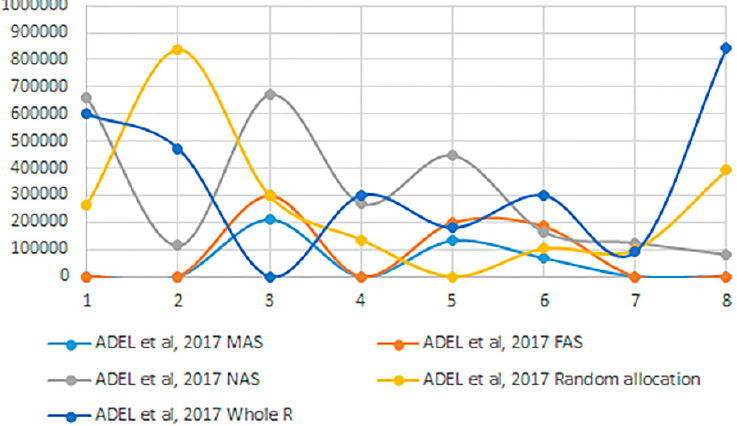
Figure 5. Problem 1, present work of this paper, transmission costs with site clustering of [7].